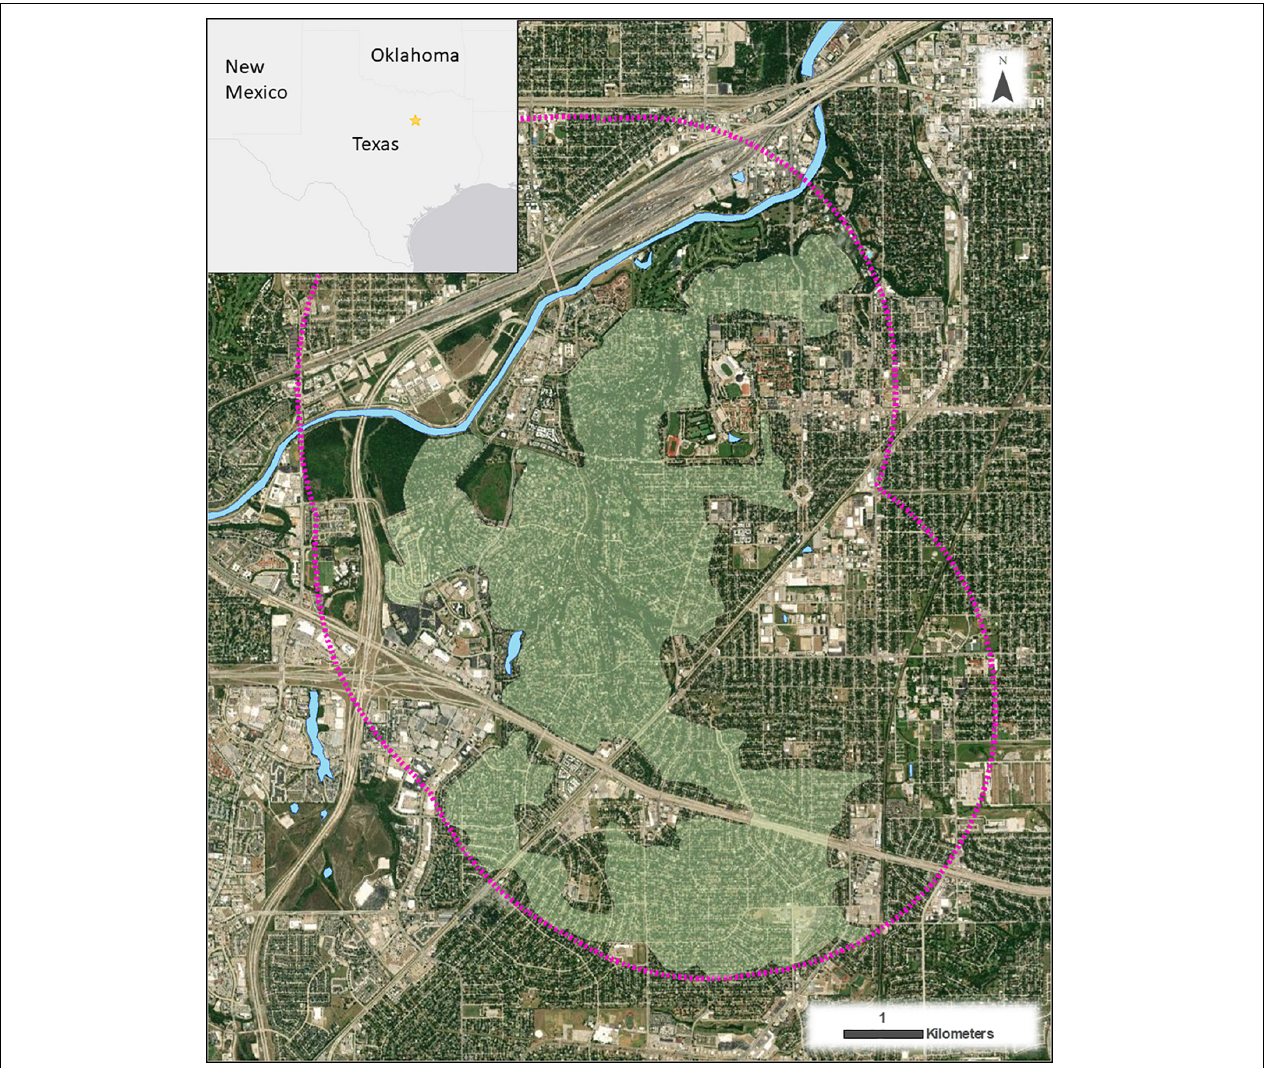
FIGURE 1 | All residents with swimming pools within a suburban neighborhood in Fort Worth, TX, United States (shown as a translucent green polygon and star on the map of Texas) received a questionnaire between 2019 and 2020. Pink dotted outline shows total study area considered prior to the search and identification of residents with swimming pools. Light blue polygons display natural and semi-natural water